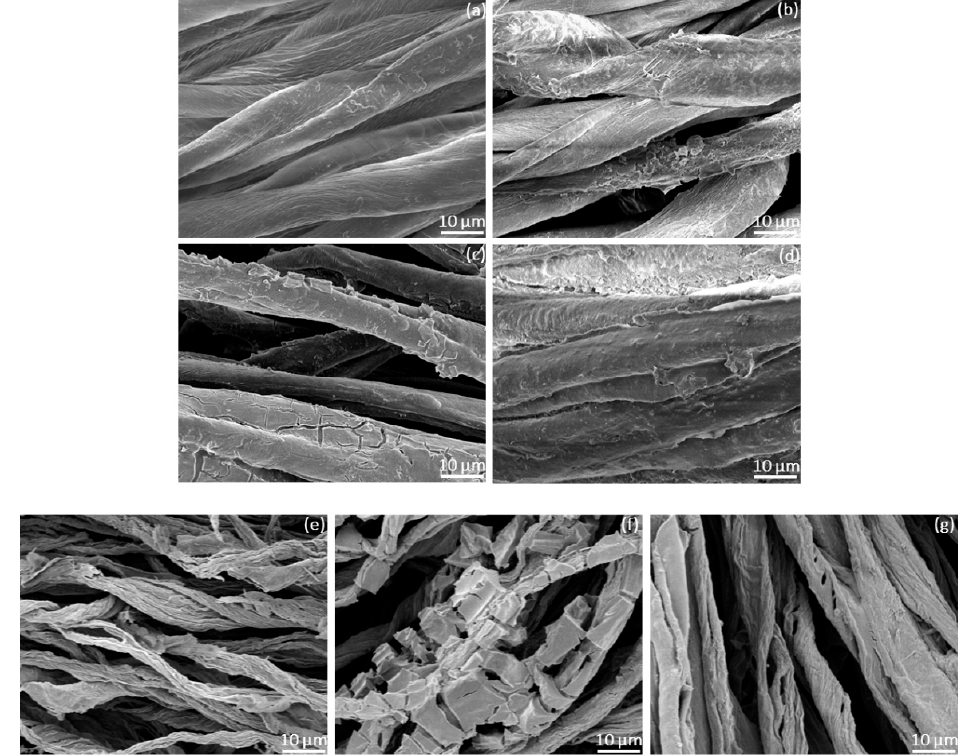
Figure 4. The SEM images of ( a ) pristine cotton; ( b ) C-Zr-MOF; ( c ) C-Zr-MOF/BPEI; ( d ) C-Zr- MOF/BPEI/VTES; ( e ) C-Zr-MOF residual chars; ( f ) C-Zr-MOF/BPEI residual chars; and ( g ) C-Zr- MOF/BPEI/VTES residual chars.